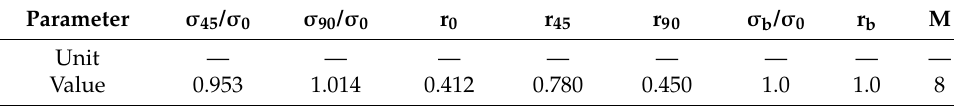
Table 2. Measured and assumed parameter values for Barlat2000 yield function.